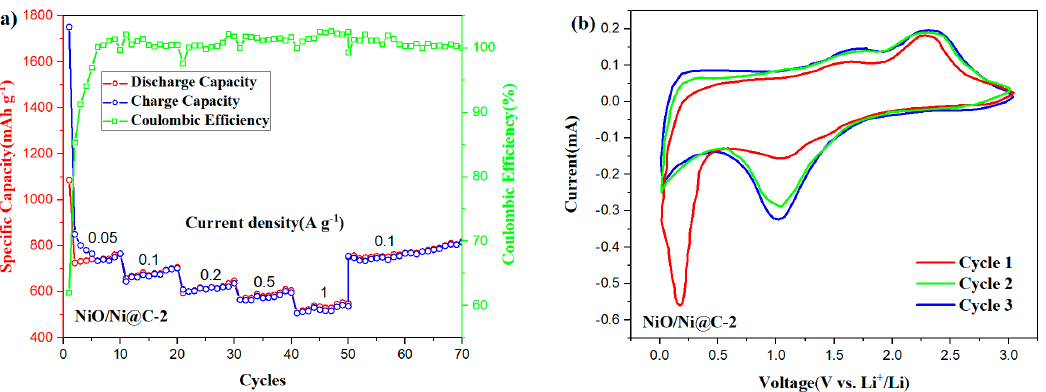
Figure 5. ( a ) Rate capacity at different specific currents, and ( b ) CV (Cyclic voltammograms) curve of the initial cycle of NiO/Ni@C-2